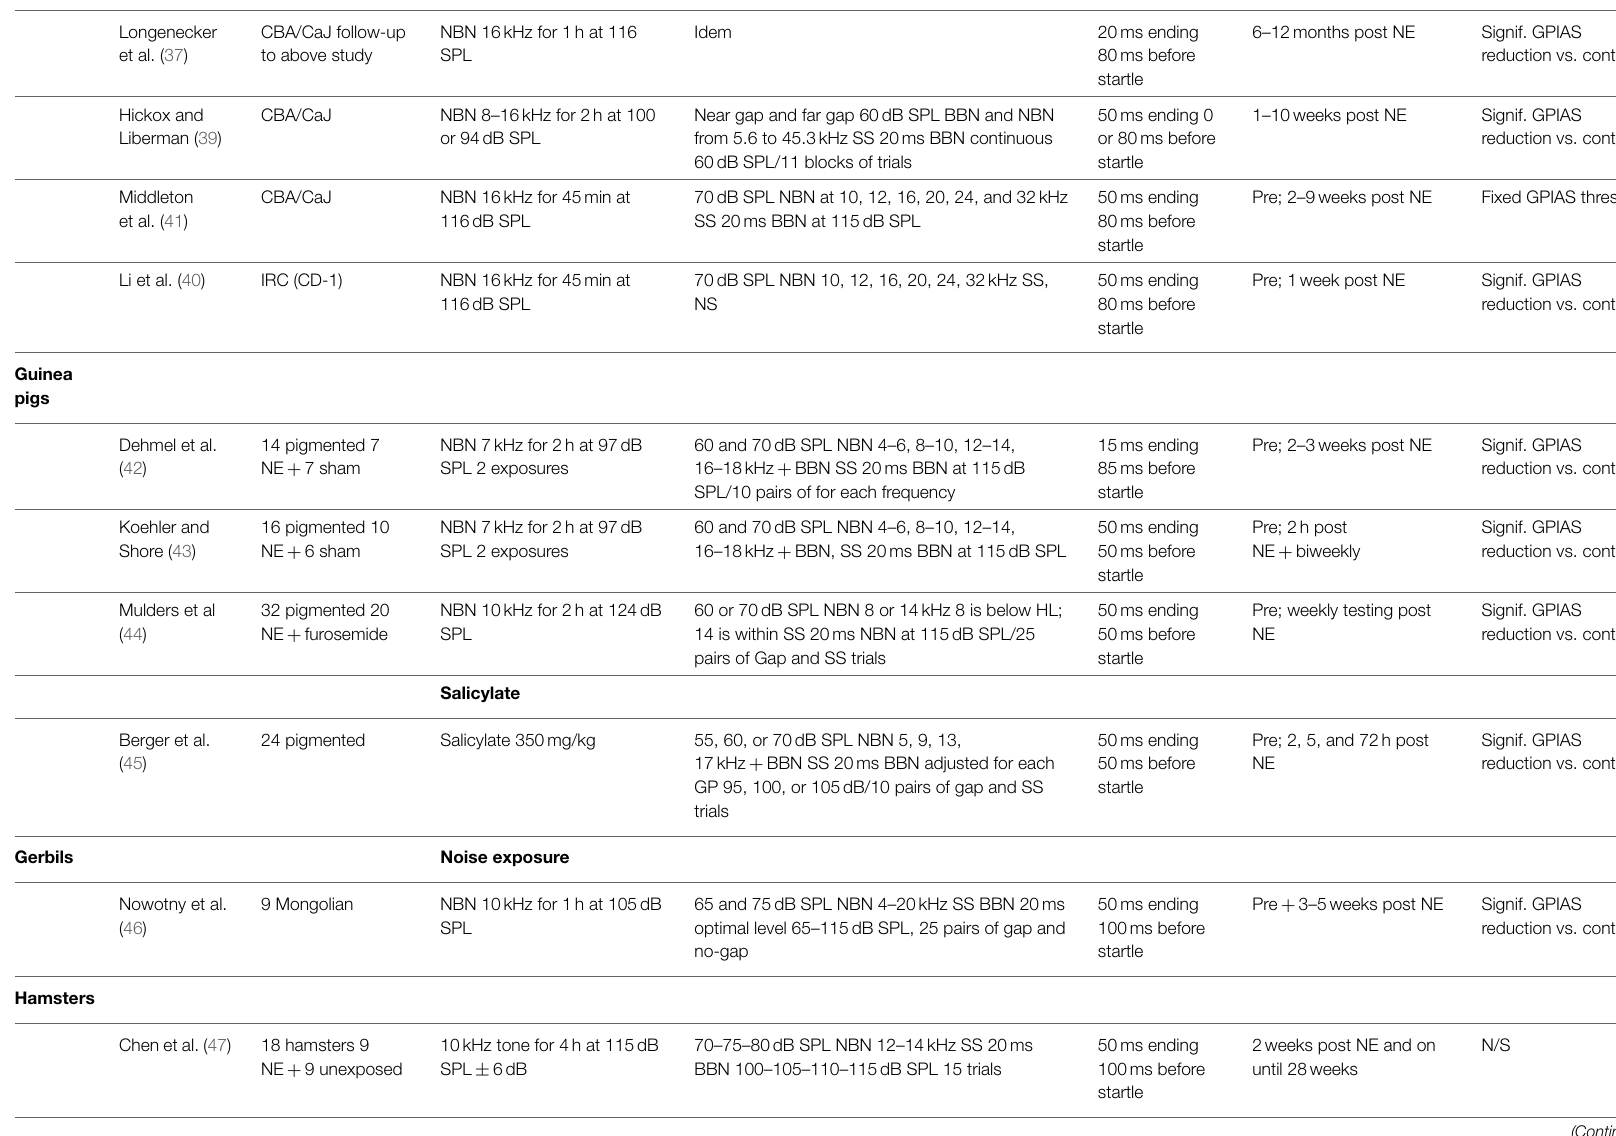
Signif. GPIAS reduction vs.